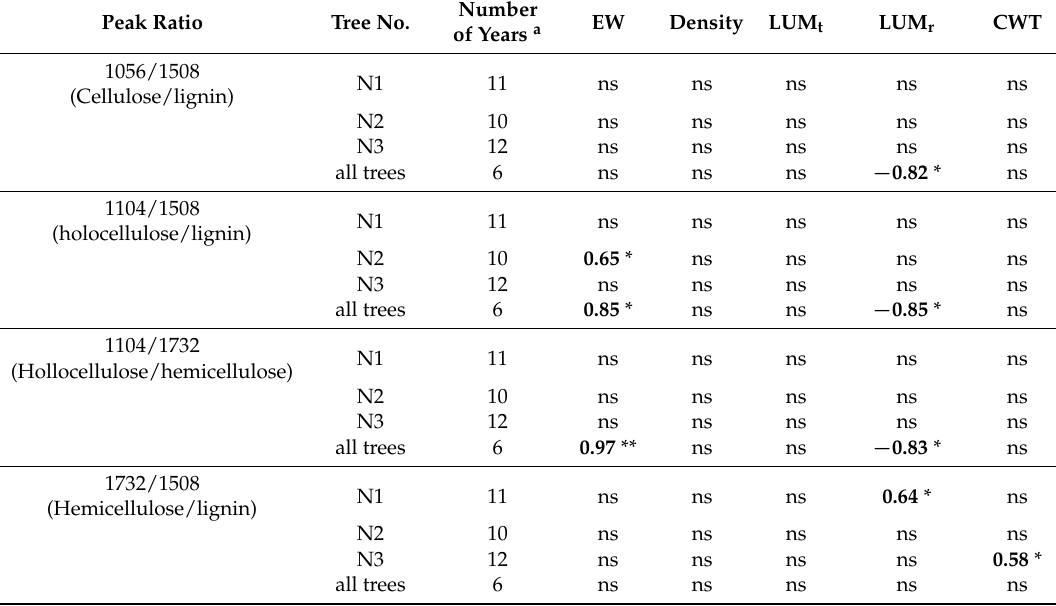
Table 3. Relationship between IR peak ratios and cell dimensions, i.e., earlywood width (EW), wood density (density), tangential lumen diameter (LUM t ), radial lumen diameter (LUM r ) and cell wall thickness